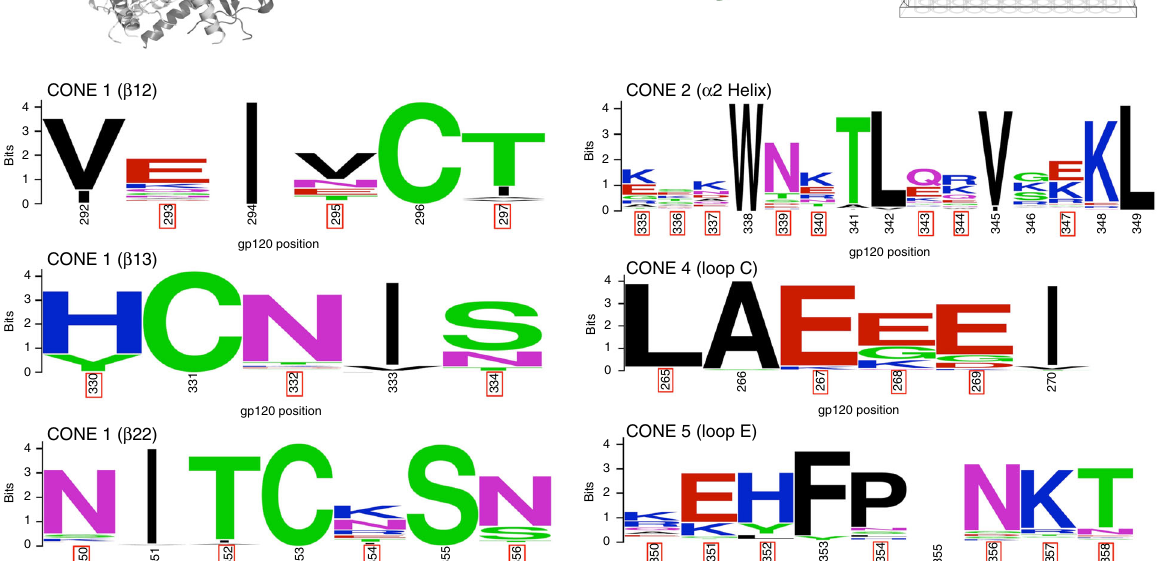
(C1S1, C2S5, and C4S3) for immunization experiments and further structural analysis.